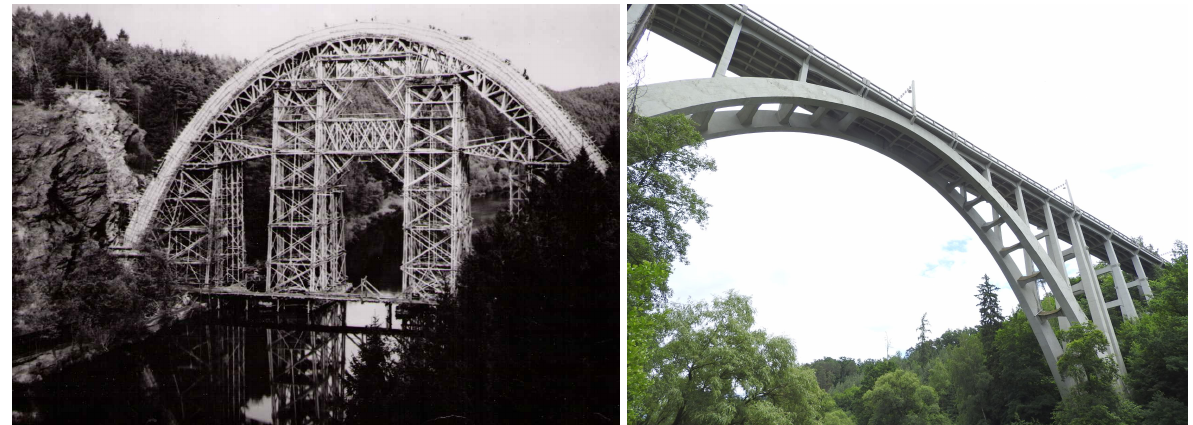
Figure 5. Arch road – railway bridge at Bechyně, 1928 (left – construction [6], right – at present).